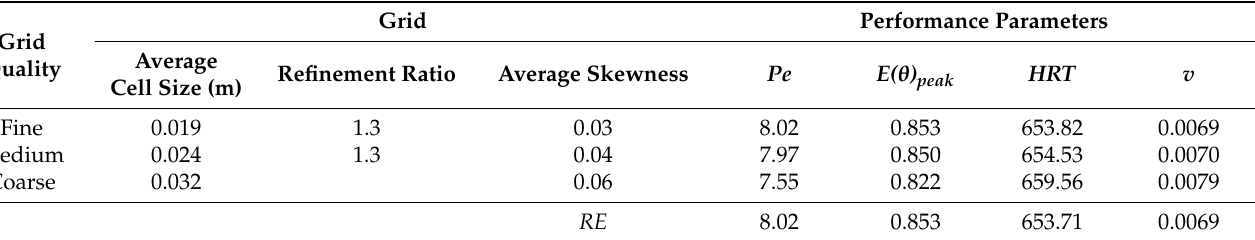
Table 3. Grid quality and performance parameters.